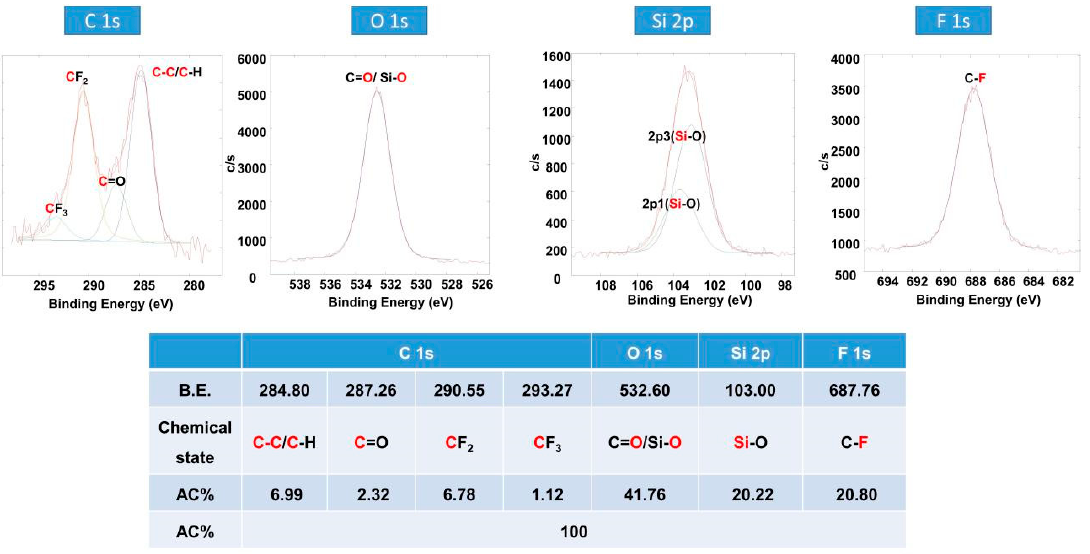
Figure 7. X-ray photoelectron spectroscopy (XPS) spectra with high resolution of four chemical states in Point 2: C 1s, O 1s, Si 2p, F 1s, and atomic concentration (AC%) of four chemical states in one sampling area.